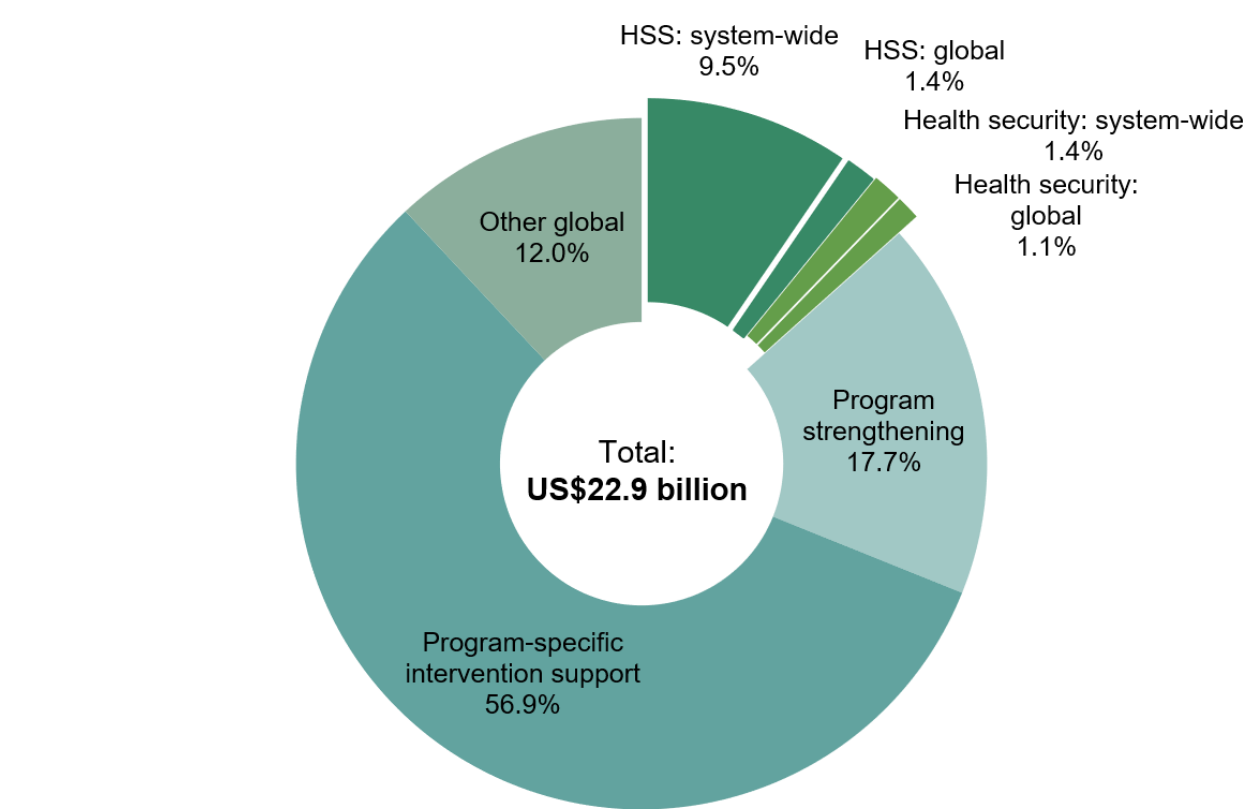
Figure 3. Distribution of total development assistance for health in 2015. HSS, health systems